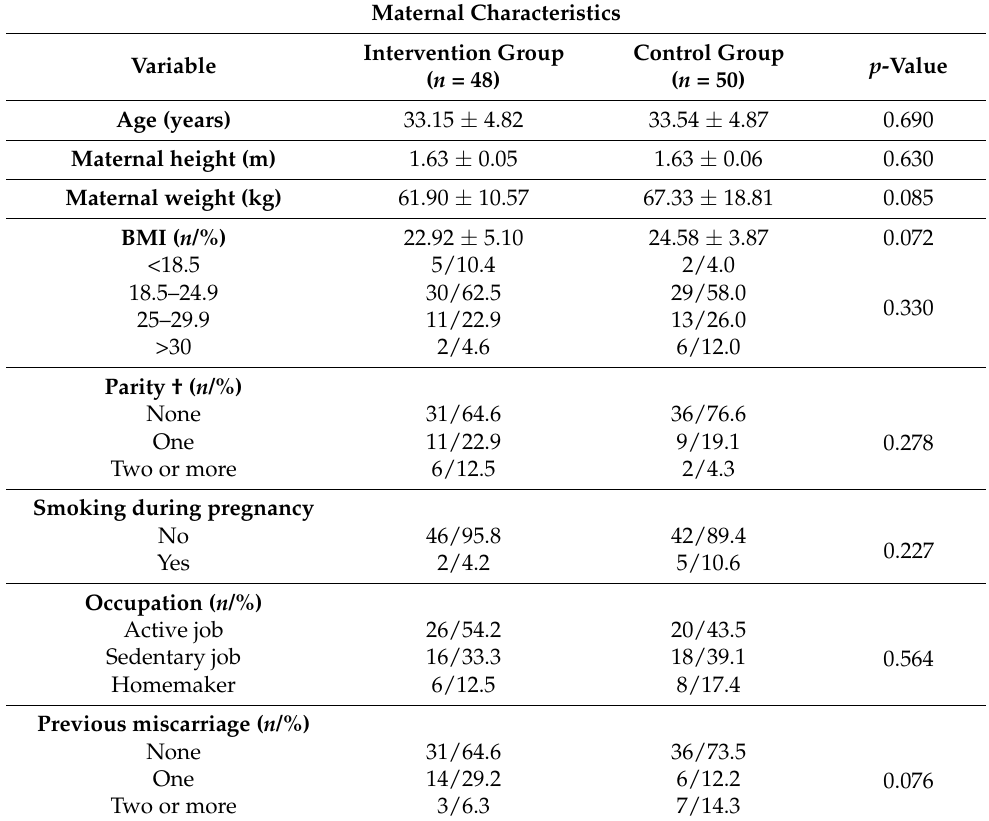
Table 1. Maternal characteristics at